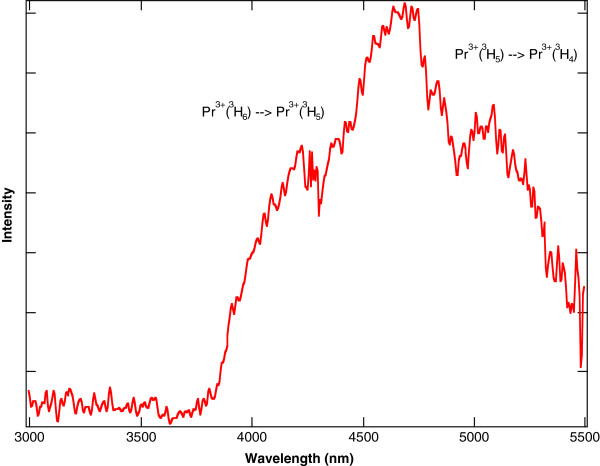
Fluorescence from 3,000 to 5,500 nm resulting from 1,483-nm pumping of Pr3+:KPb2Cl5. The sample has a Pr3+ concentration of 1.5 × 1020 ions/cm3.